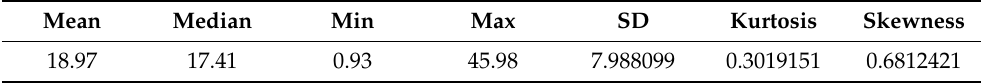
Table 5. Statistical characteristics of the “Water Demand” dataset.